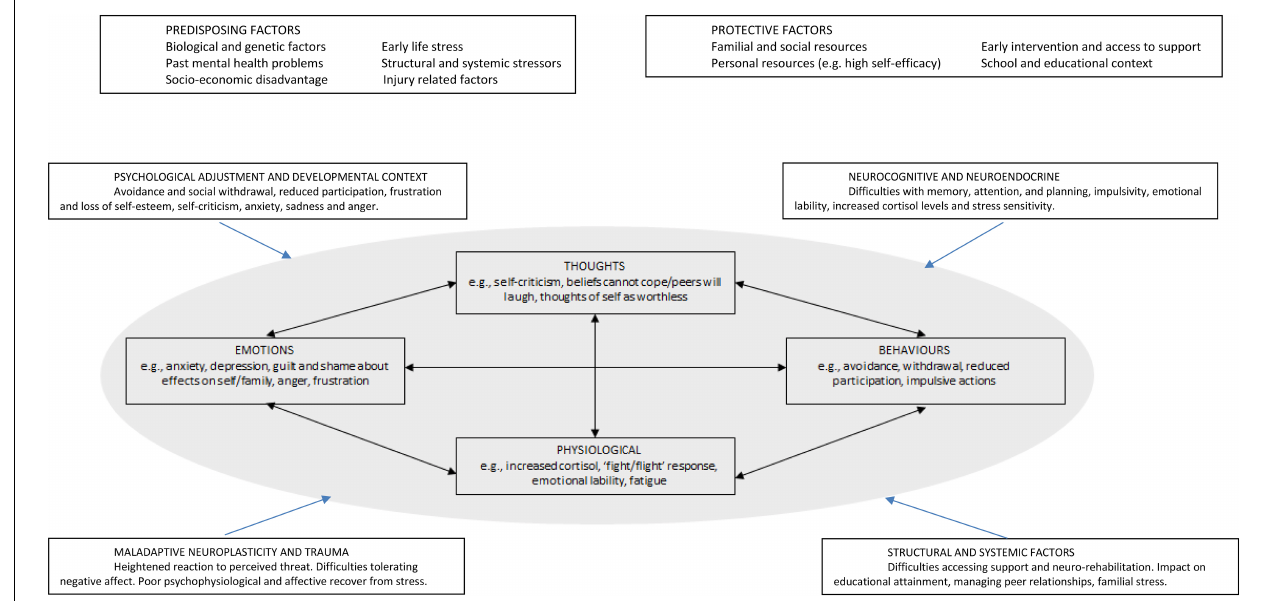
FIGURE 1 | A framework for formulating mood disorders in paediatric acquired brain